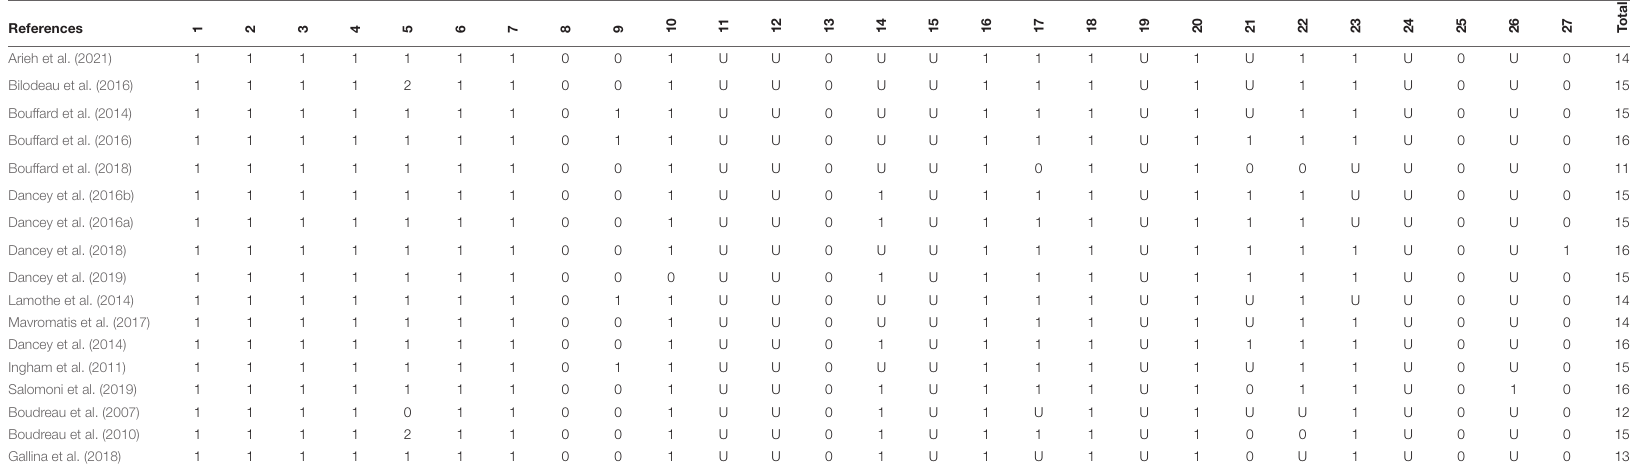
TABLE 2 | Quality assessment of the included